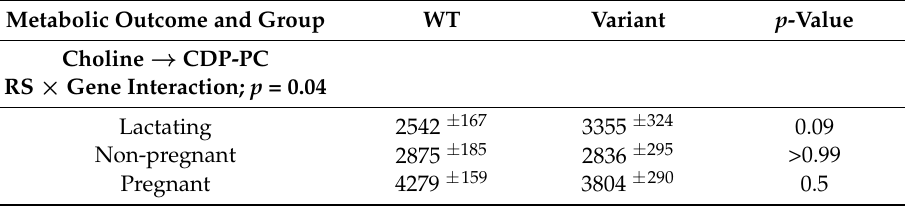
Table 4. Comparison of choline → CDP-PC turnover between genotypes by reproductive state. Values are least-squared means ± standard errors in ratios.